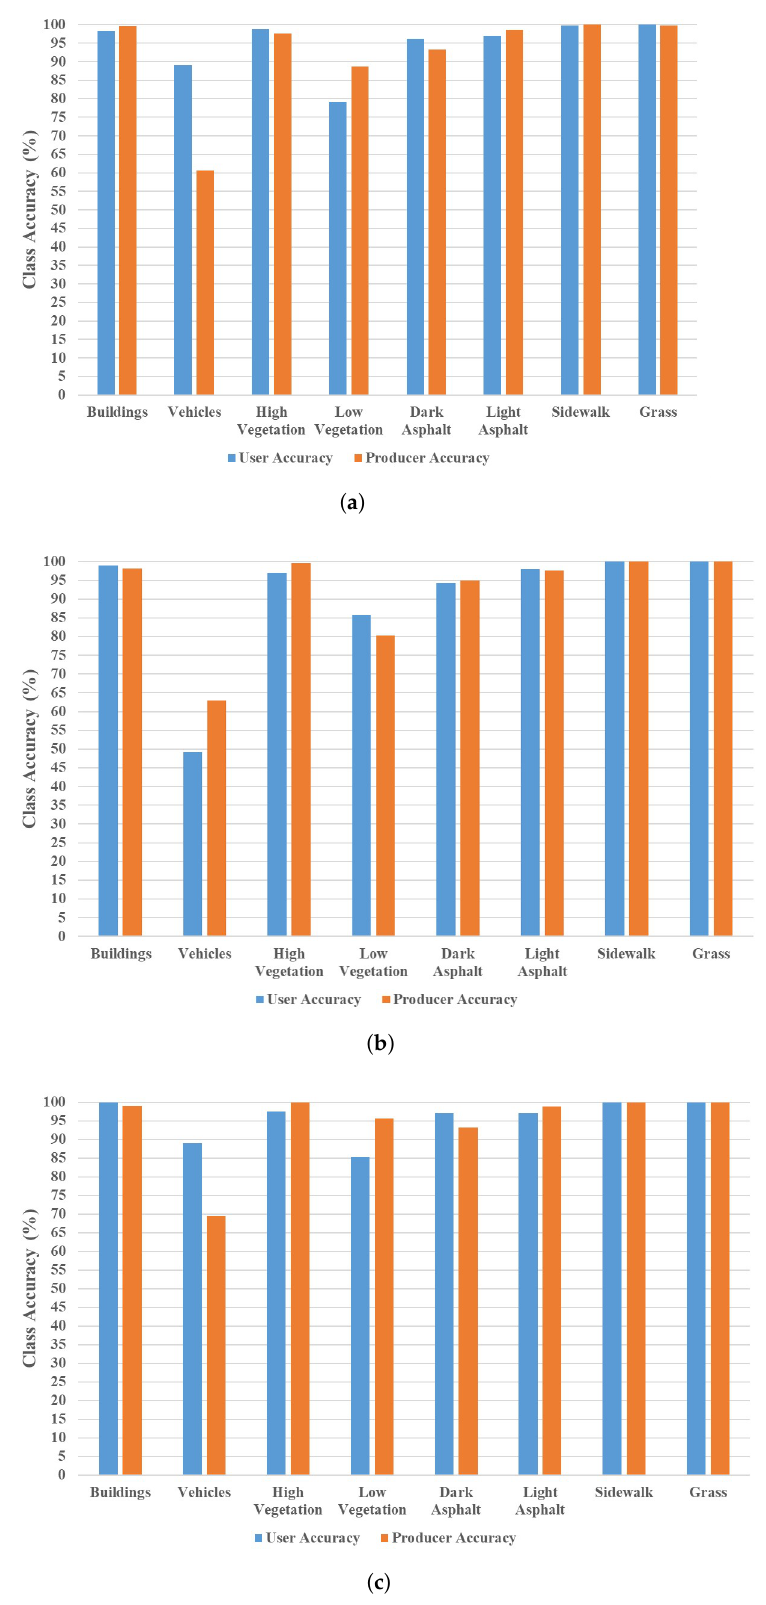
Figure 16. Class accuracy (test set): scenario-3. ( a ) ML classification. ( b ) SVM classification. ( c ) MLP neural network